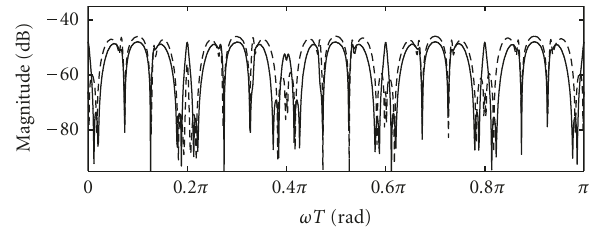
Figure 12: Magnitude responses of the aliasing functions without the nonlinear optimization procedure with N G = 39 and N F = 58, Example 1.